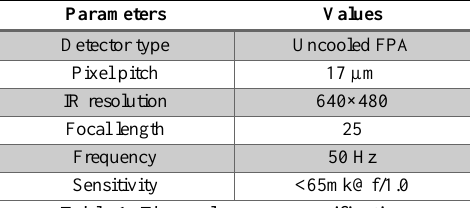
Table 1: Thermal camera specification